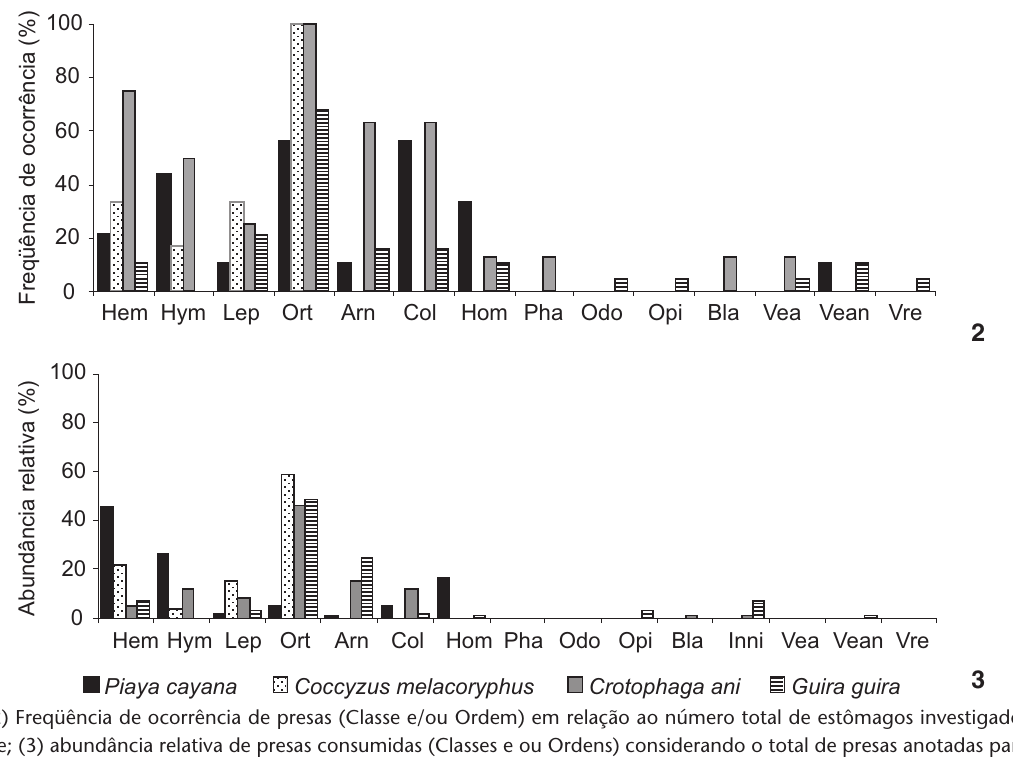
Figuras 2-3. (2) Freqüência de ocorrência de presas (Classe e/ou Ordem) em relação ao número total de estômagos investigados para cada Cuculidae; (3) abundância relativa de presas consumidas (Classes e ou Ordens) considerando o total de presas anotadas para cada espécie de Cuculidae. Coleoptera (COL), Homoptera (HOM), Hemiptera (HEM), Hymenoptera (HYM), Lepidoptera (LEP), Orthoptera (ORT), Phasmida (PHA), Blattaria (BLA), Odonata (ODO), Araneae (ARN), Opiliones (OPI), Reptil (VRE), Ave (VEA), Anuro (VAN), Invertebrado indeterminado